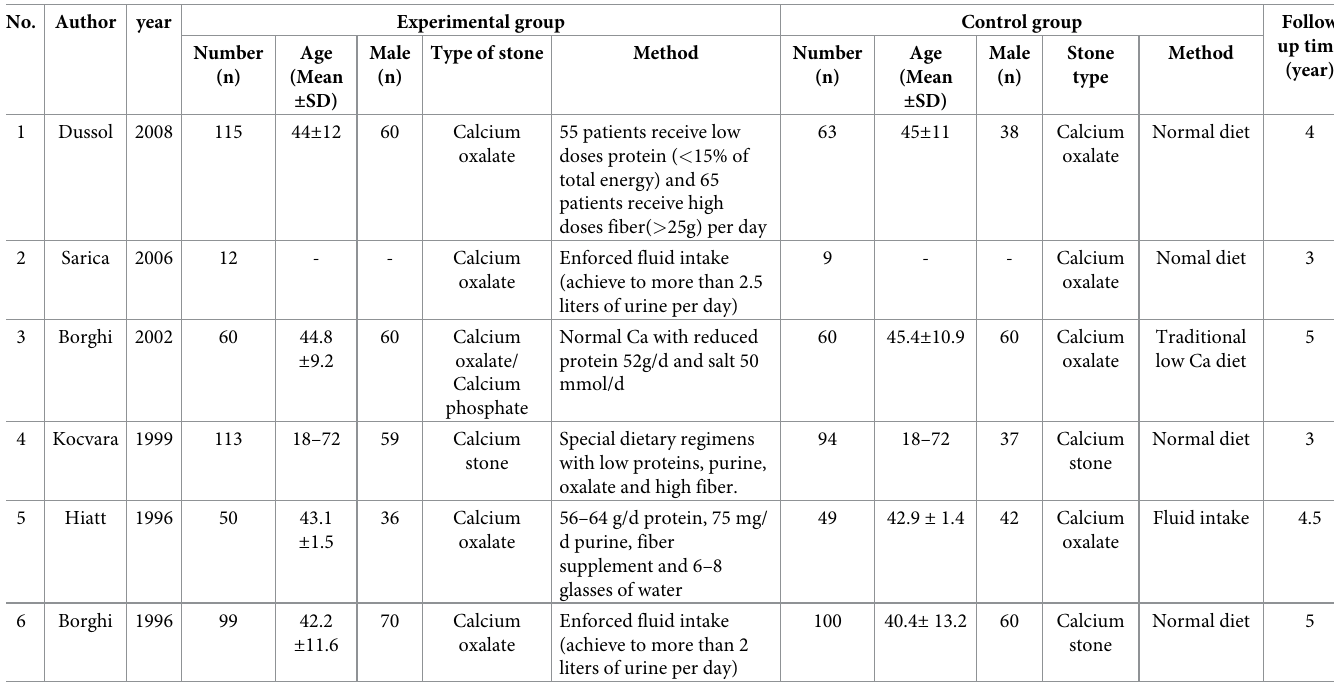
Table 1. Characteristics of included